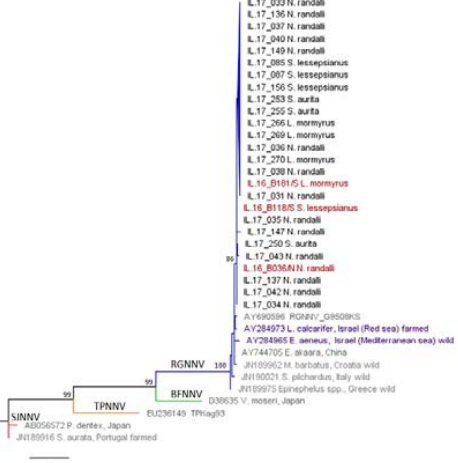
Figure 3. RNA2 phylogenetic tree. Maximum likelihood (ML) phylogenetic tree of the RNA2 partial sequences. The sequence name includes the identification number and host species. Positive samples of this study (begins with IL) are in black, reference sequences from GenBank are in grey or purple for isolates from Israel, and representative sequences from 2016 [21] are in red. NNV genotype subdivision is displayed on the branches (blue: RGNNV; green: BFNNV; yellow: TPNNV; red: SJNNV). The numbers at the branches nodes represent bootstrap values (only values ≥ 70% are reported). The scale bar represents 0.2 nucleotide substitution per